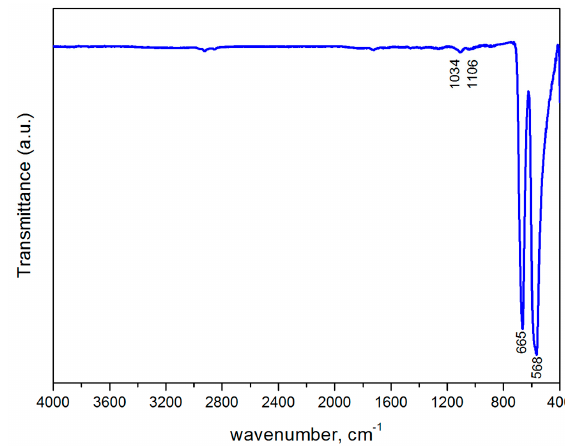
Figure 5. FT-IR spectra of Co 3 O 4 nanoparticles.